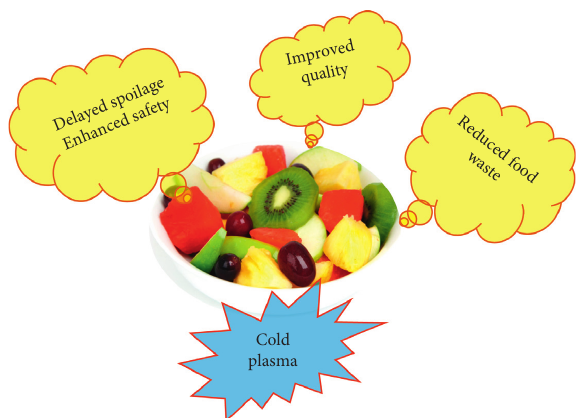
Figure 3: The influence of cold plasma on the quality and safety of